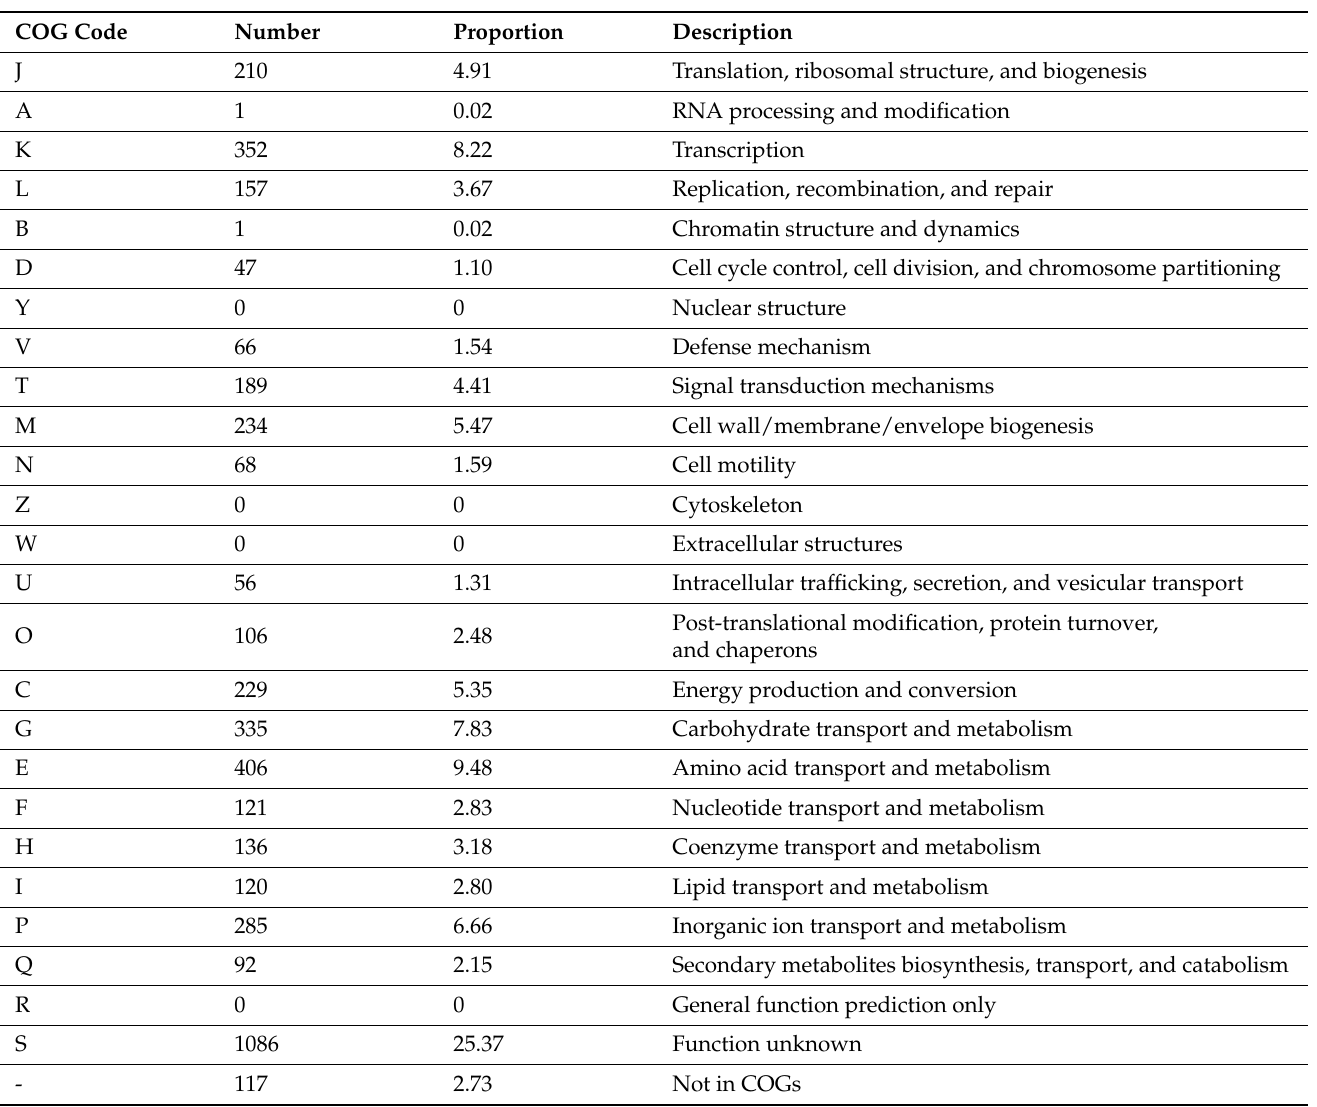
Table 2. COG categories of Bacillus subtilis